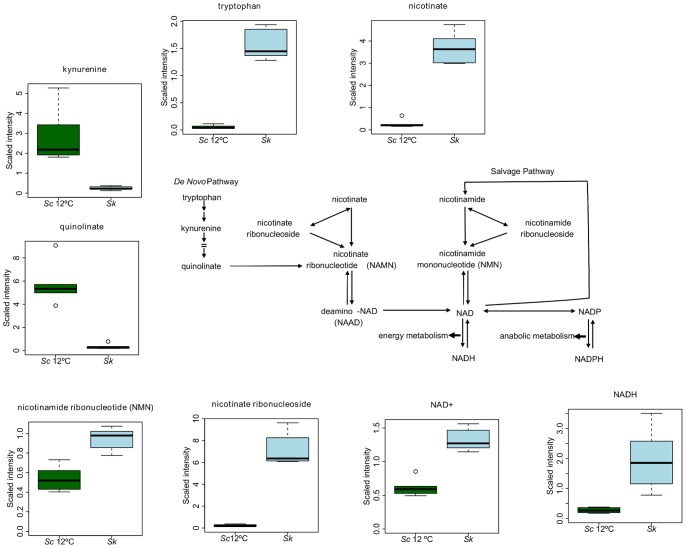
The NAD+ biosynthesis pathway.Differentially produced metabolites within Sk and Sc. Box legend: bar inside the box represents the median value, upper bar represents maximum of distribution, lower bar represents minimum of distribution and the circle represents extreme data points.